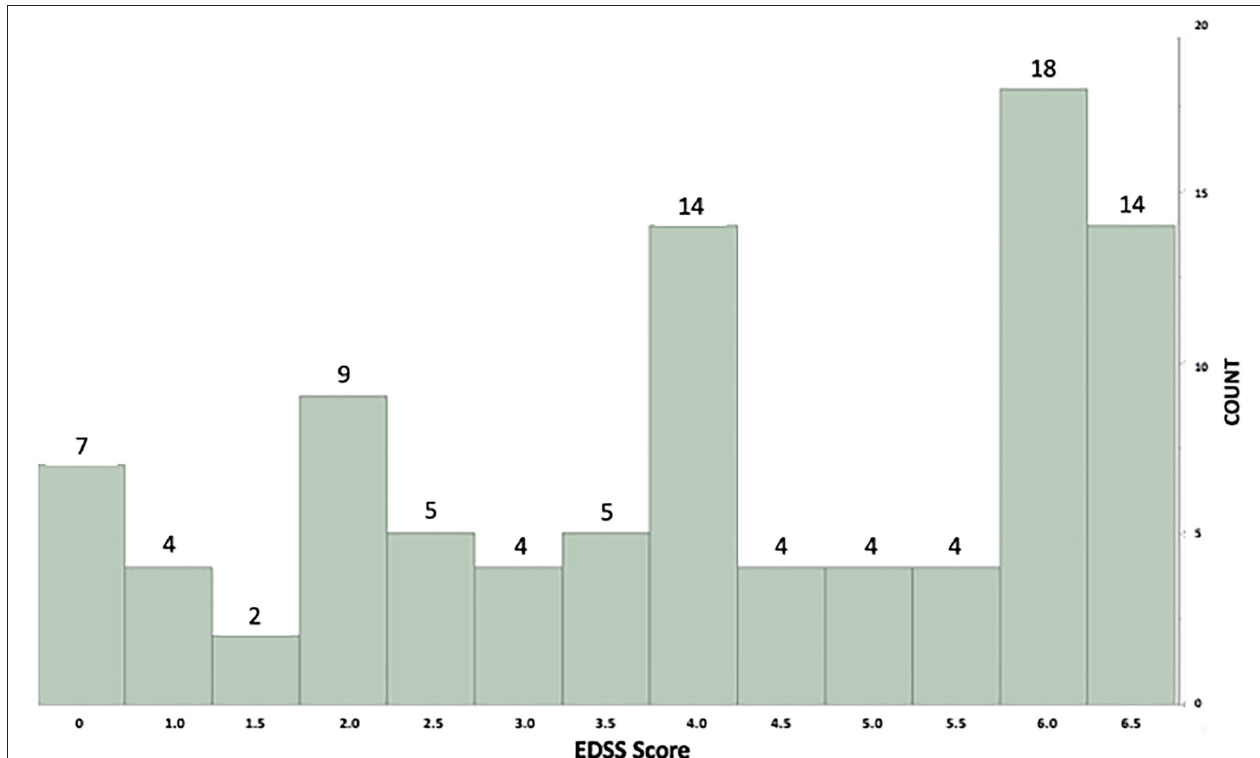
FIGURE 1 | Histogram showing individual example of minute-by-minute step count distribution with the GMM model fit. X axis = Expanded Disability Status Score (EDSS) scores. Y axis = Number of subjects in each EDSS level.